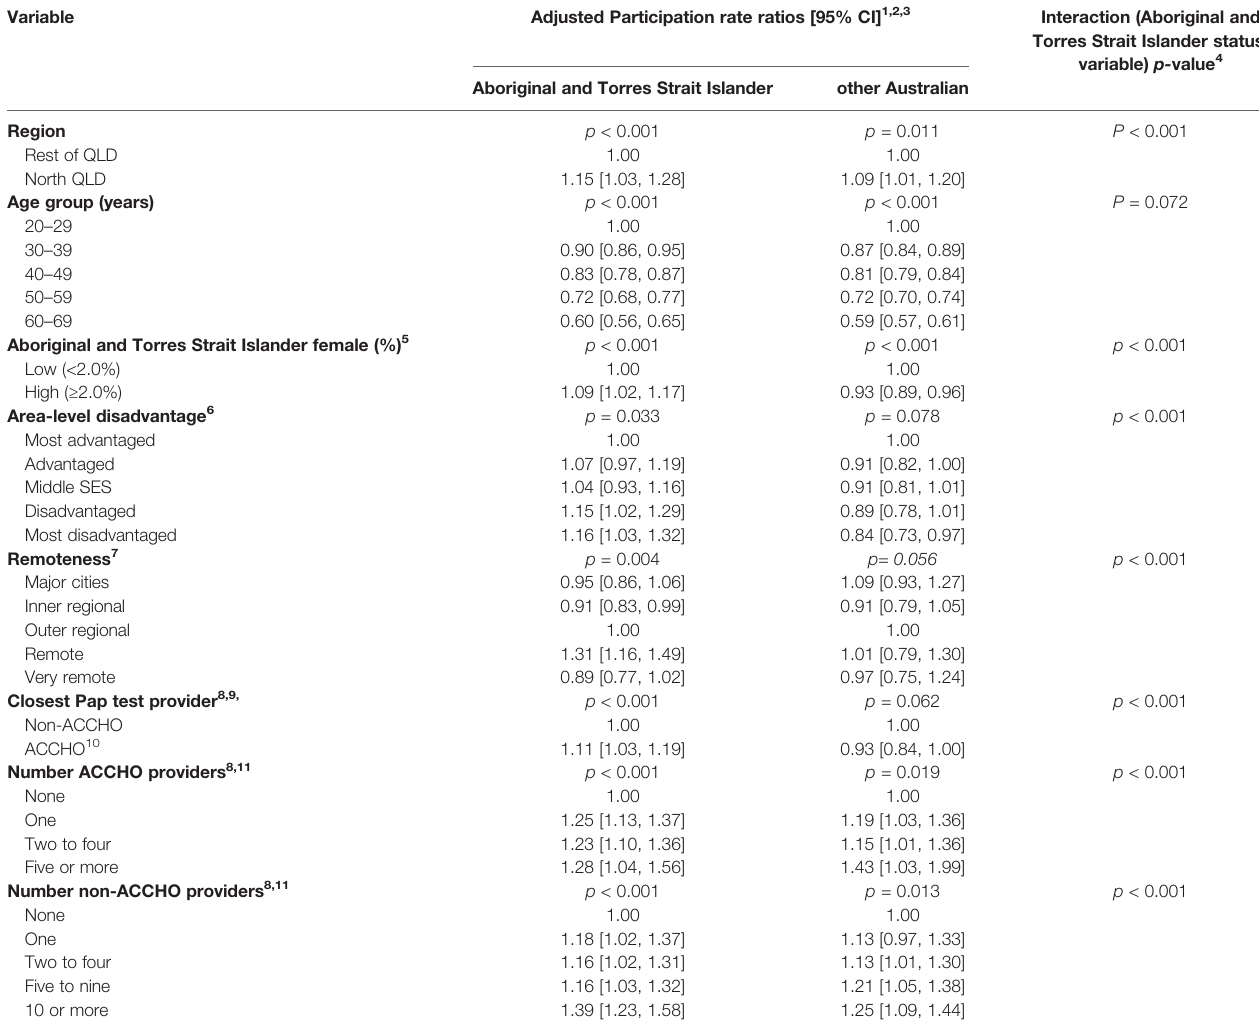
TABLE 3 | Participation rate ratios (PRR) [95% CI] for cervical screening by region, for Aboriginal and Torres Strait Islander women aged 20 – 69 years, Queensland, Australia, 2013 – 2017.